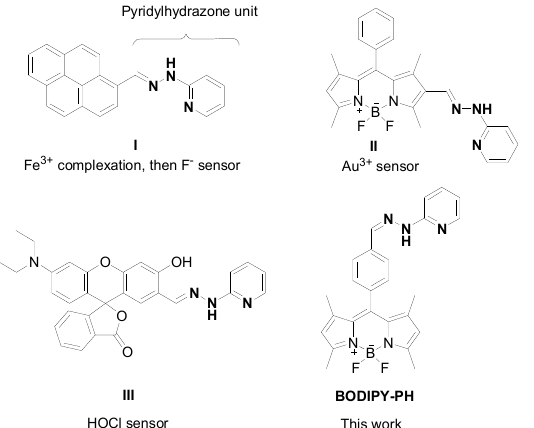
Figure 1. Structures of pyridylhydrazone-based fluorescent sensors in the literature and the BODIPY-PH in this work.